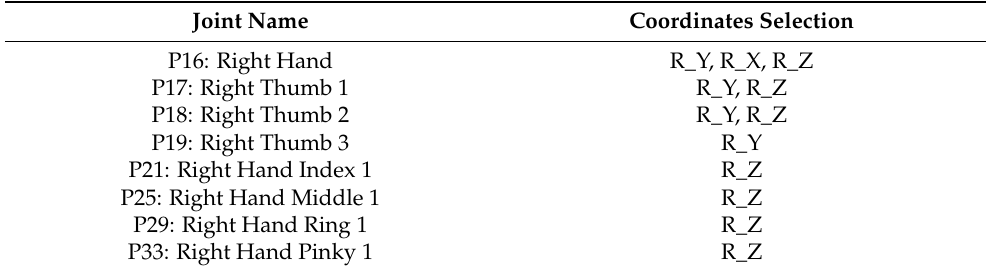
Table 1. Selected coordinates of right-hand joints.